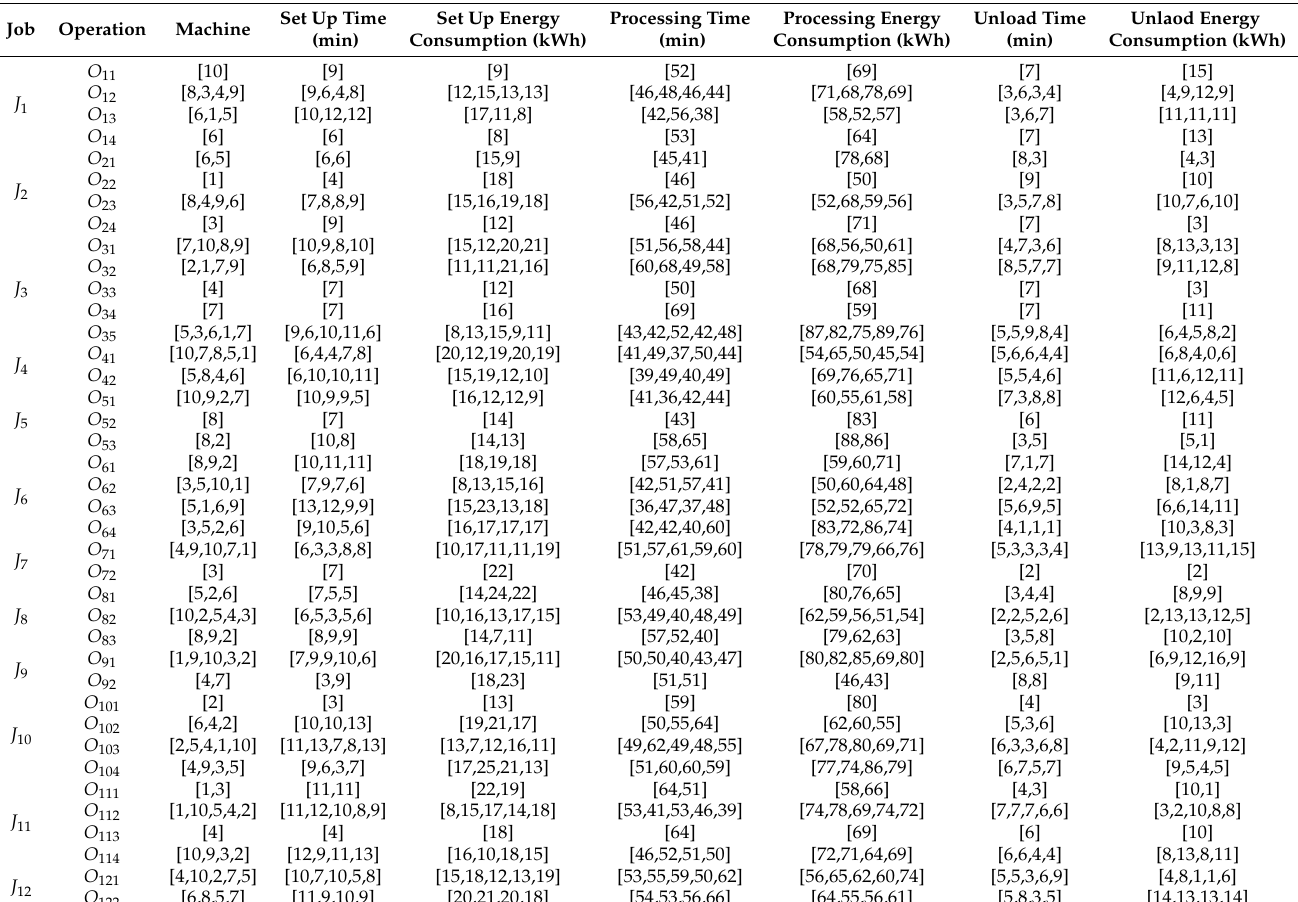
Table 9. The job shop information of Instance 3.